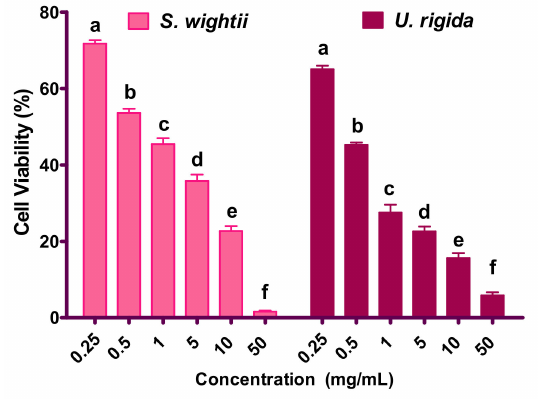
Figure 4. Cytotoxicity of ethanolic extract of S. wightii and U. rigida at different concentrations (from 0.25 g/mL to 50 mg/mL) measured by MTT assay. Data are expressed as mean ± SD (n = 3). Mean values bearing different superscript letters (a,b . . . ) differ significantly at p < 0.05 in Duncan’s multiple comparison post hoc